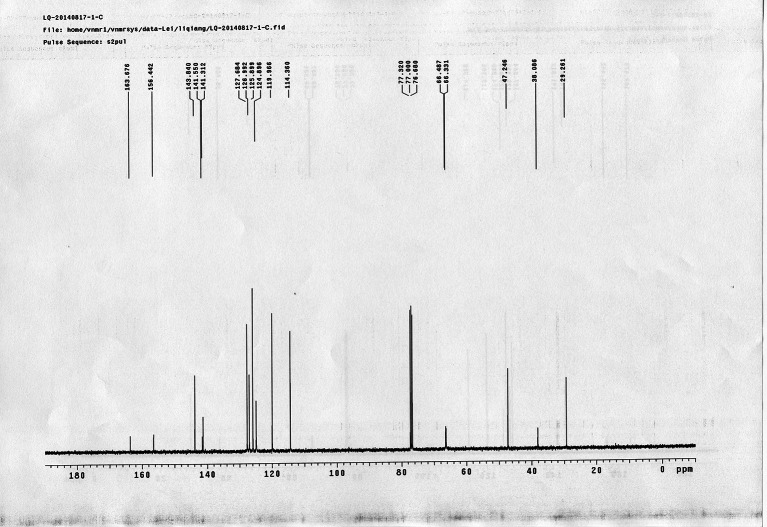
13C NMR spectra of compound 20.